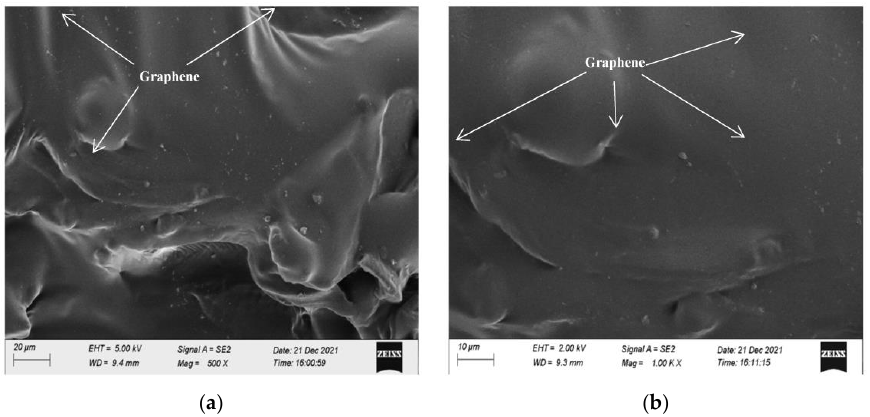
Figure 11. Microstructure of dispersed graphene asphalt. ( a ) 500 times, ( b ) 1000 times.